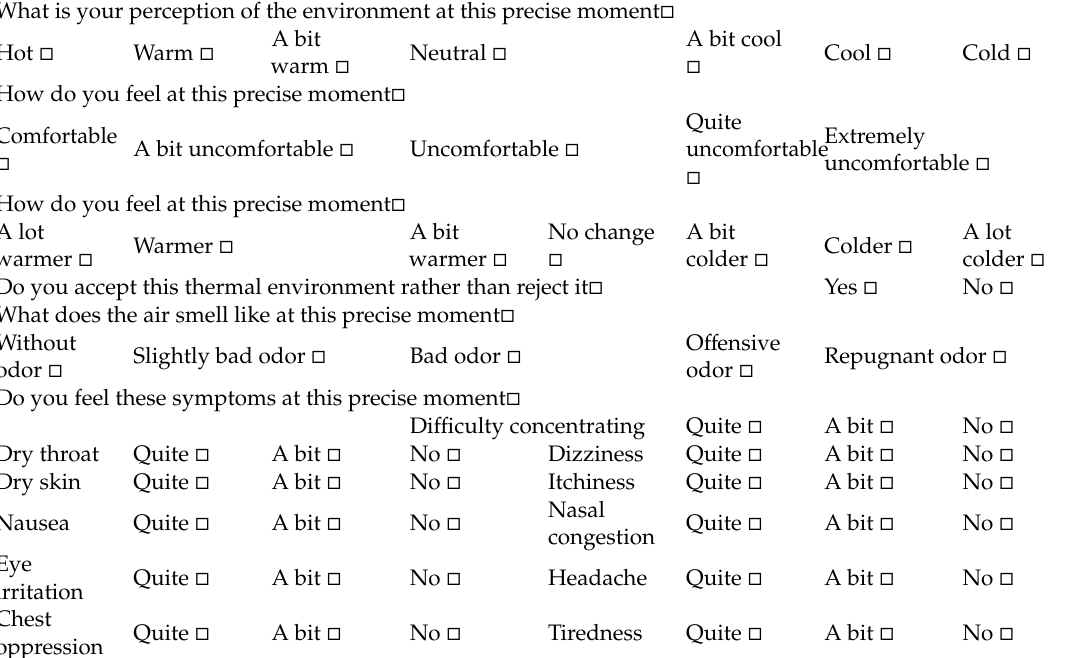
Table A1. Excerpt from the surveys distributed to